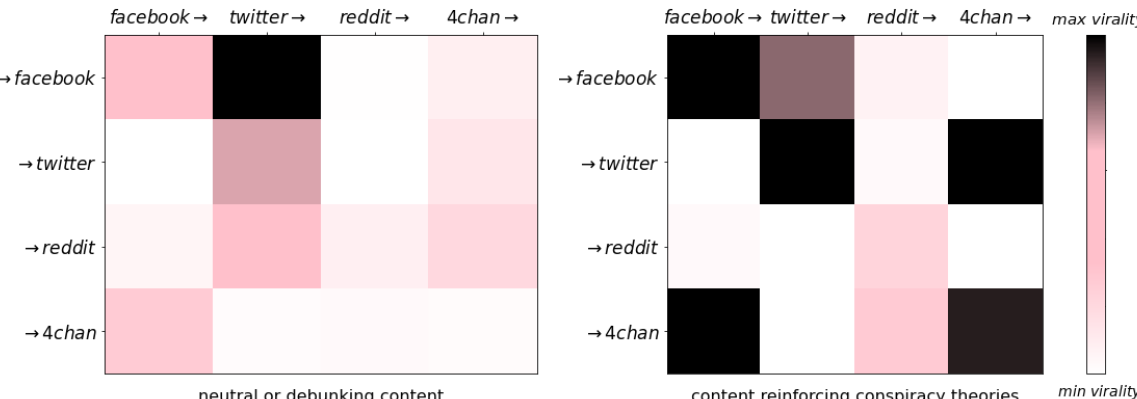
Figure 1. Heatmap depicting the virality of conspiracy theory reinforcing and neutral/debunking stories about the origin of COVID-19. The darker the color, the higher the virality of URLs, as calculated by virality parameter α. The heatmap describes how each platform in a column affected other platforms. For example, the first column shows how stories on Facebook affected the virality of similar stories on itself, Twitter, Reddit, and